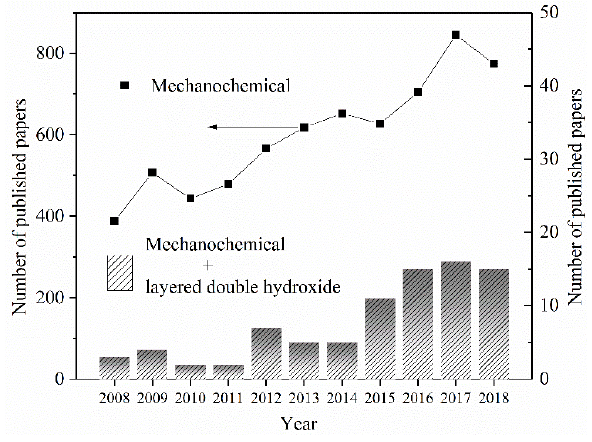
Figure 1. The number of published papers with topics on mechanochemical, mechanochemical, and layered double hydroxide, respectively (literature search in the database of Web of Science).